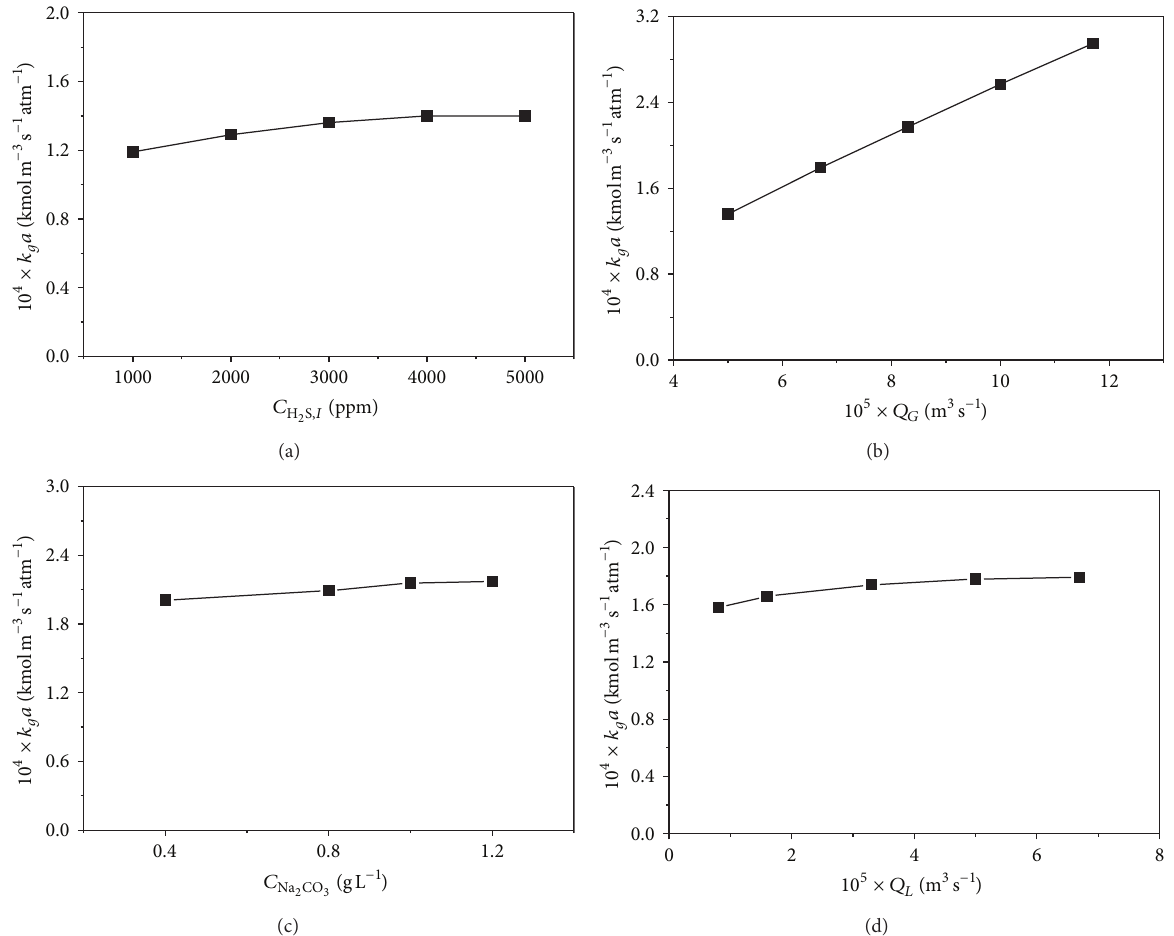
Figure 4: The influences of different parameters on 𝑘 𝑔 𝑎 : (a) H 2 S concentration; (b) gas release rates; (c) Na 2 CO 3 concentrations; (d) water flow